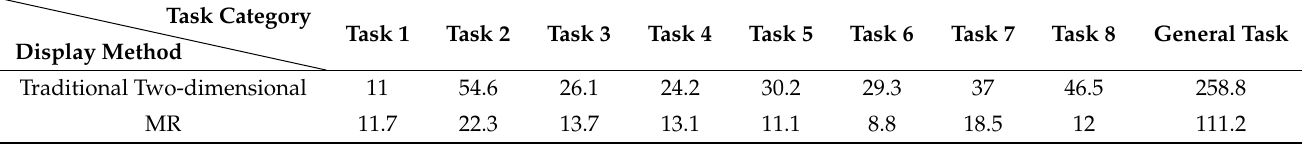
Table 2. Average time to complete tasks using traditional 2D display interaction system and using MR display interaction